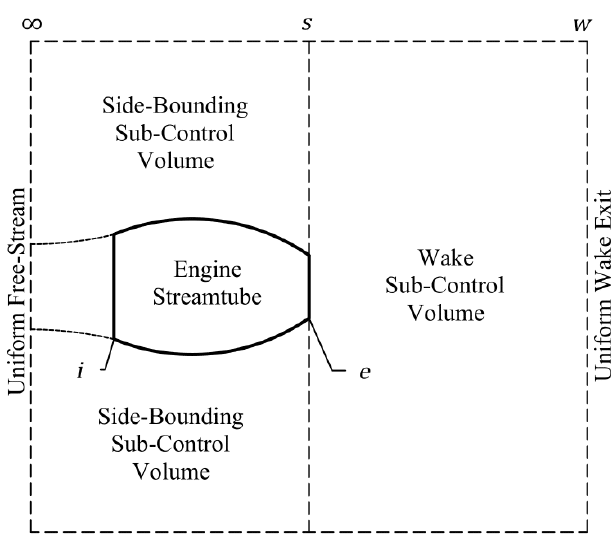
Figure 2. Global control volume for stand-alone gas turbine engine exergy analysis.